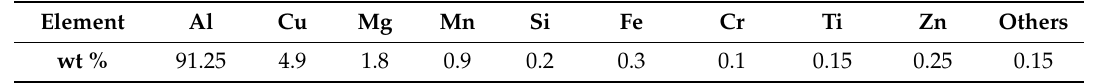
Table 1. Chemical composition of the 2124 aluminum powder